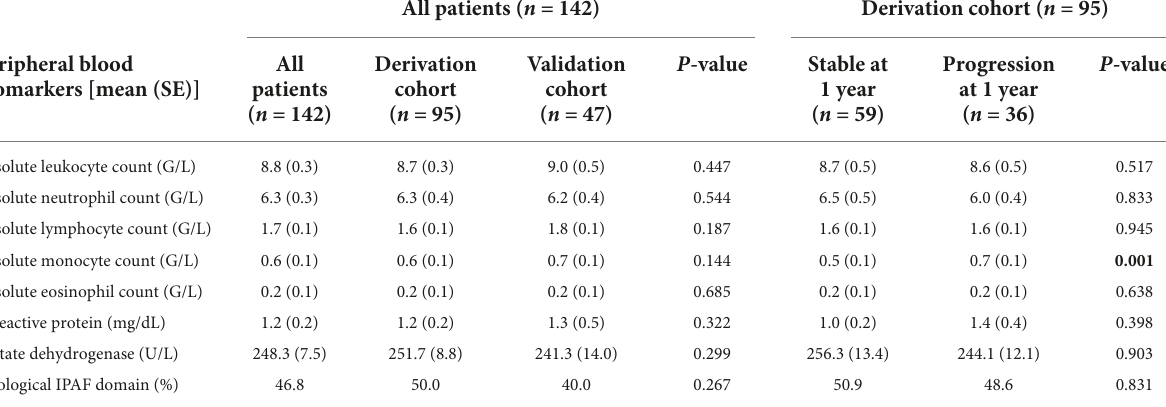
TABLE 2 Baseline peripheral blood biomarkers in all patients, the derivation, and the validation cohort as well as in the derivation cohort according to progression at 1 year. All patients ( n =